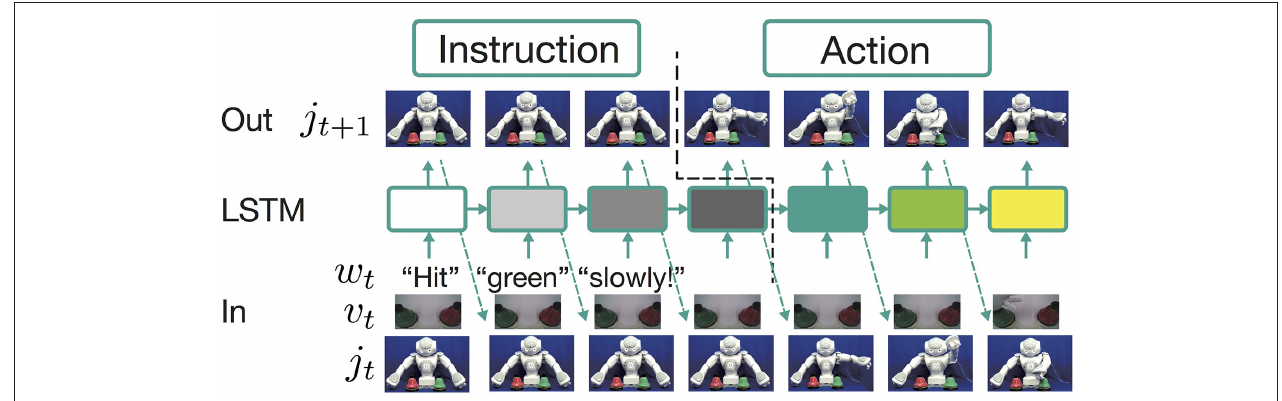
FIGURE 1 | The framework employed to learn the current tasks. The learning model is a three-layer neural network whose middle layer is an LSTM layer. At each time step, the model receives word w t , visual information v t , and the current robot joint angles j t . The LSTM layer calculates the current output h t from these external inputs, the memory cell state c t , and its own output in the previous step h t − 1 . The output layer is a fully connected layer. It receives the output of the LSTM layer and predicts the appropriate joint angles for the next time step. In this process, receiving an instruction and generating an action are completely conducted in the forward propagation algorithm. An instruction sentence, visual information, and the robot’s current posture are encoded as the states of memory cells in the LSTM layer. After receiving the instruction, a corresponding action sequence is generated by decoding the integrated